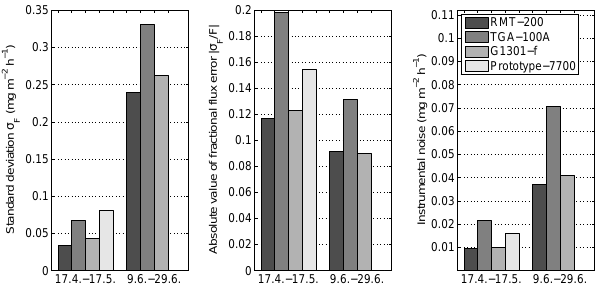
Fig. 4. From left to right: standard deviation of the covariances, absolute value of fractional flux error ( | σ F /F | ) and instrumental noise. Median values for these three statistical parameters were cal- culated during two separate periods. Fractional flux error is calcu- lated as a ratio between the standard deviations and the flux values. Instrumental noise was estimated using method proposed by Billes- bach (2011).